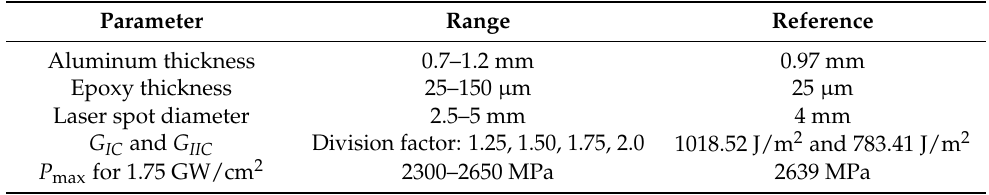
Table 3. Parameter’s range of the parametric study and reference parameters.